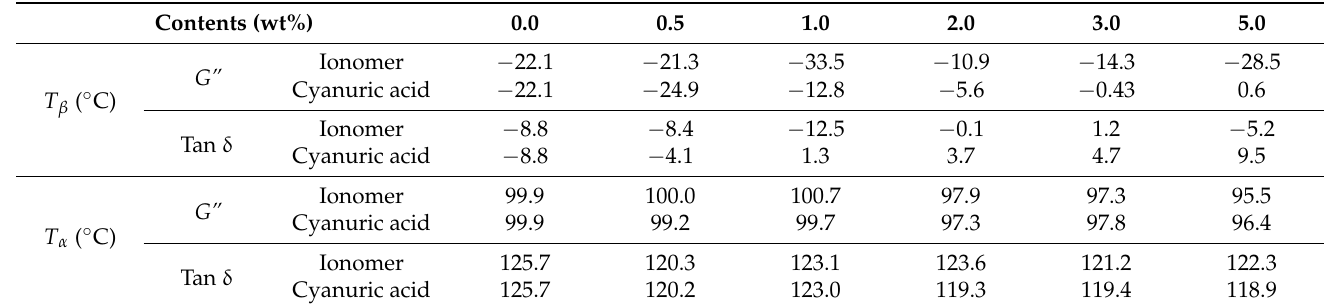
Table 5. Transition temperatures of POM/C1.5, POM/C1.5/I, and POM/C1.5/A nanocomposites with different additive concentrations, based on DMA data.